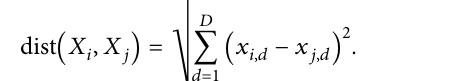
K-means clusters